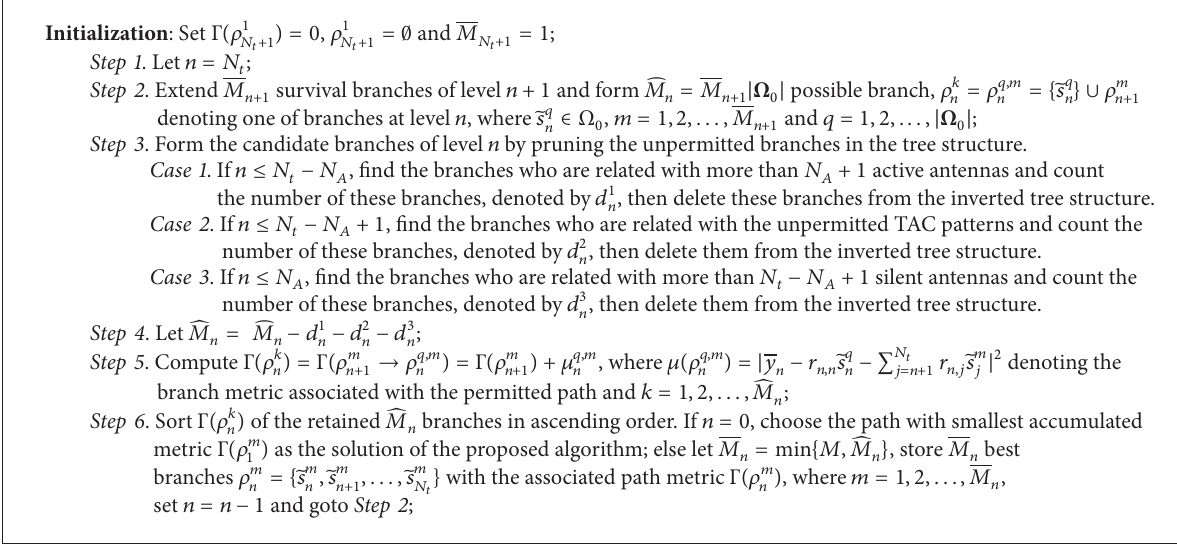
Algorithm 1: Improved QRD-M algorithm for GSM